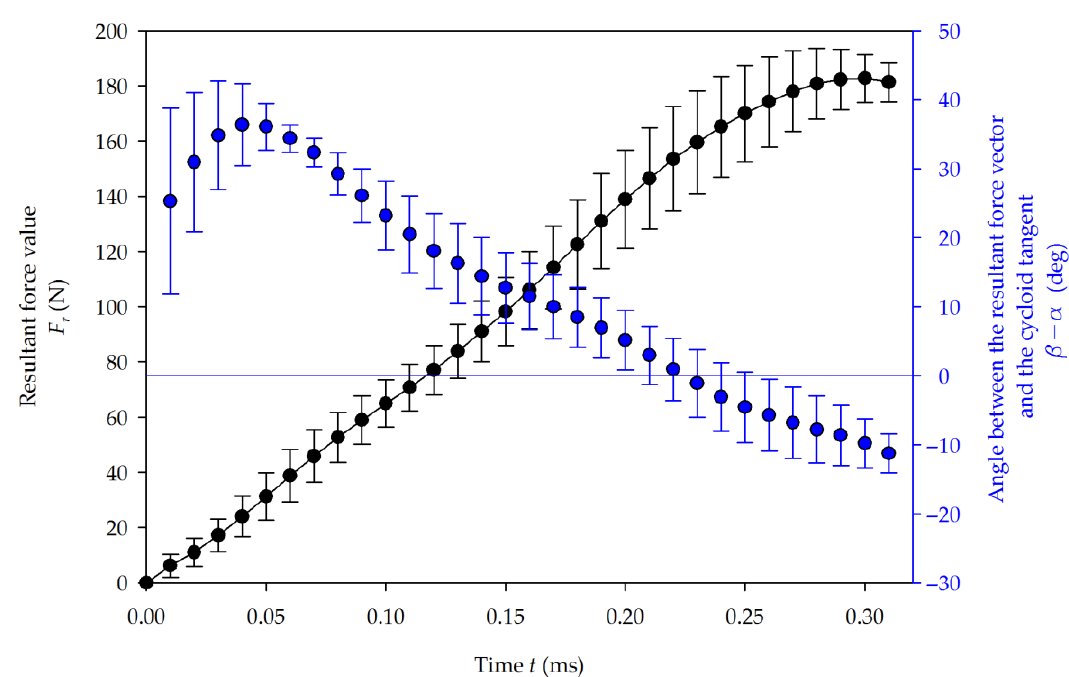
Figure 8. Average resultant force value Fr (black) and its angle α (blue) in the function of time for fast cutting.